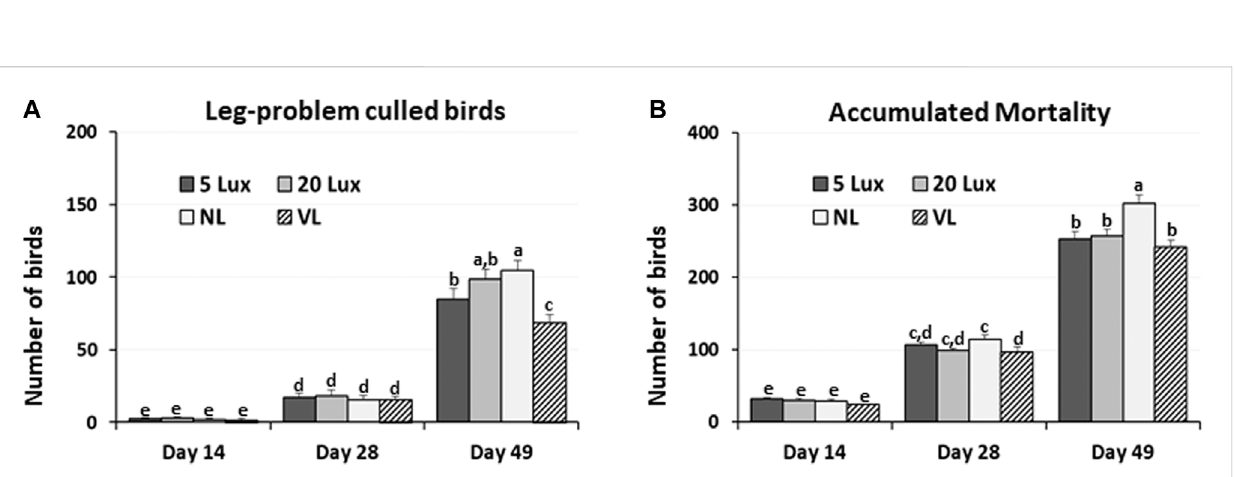
FIGURE 4 Accumulated number of birds that were culled by leg-problems and mortality in four different lighting programs (5 lx, 20 lx, NL, and VL) at different ages. (A) In each section of trial 1 and 3, the accumulated number of birds that were culled because of leg-problems and total dead birds were obtained fromday7today14(Day14),day7 – 28(Day28)andday7 – 49(Day49). (B) Accumulated mortalityfromtrial1andwasobtained fromday7today14(Day 14), day 7 – 28 (Day 28) and day 7 – 49 (Day 49). Data (mean ± SEM) were compared among treatments. Different lower-case letters above the bars denote signi fi cant differences ( p < 0.05) among groups, where a > b > c > d > e > f and a,b is not different from a or